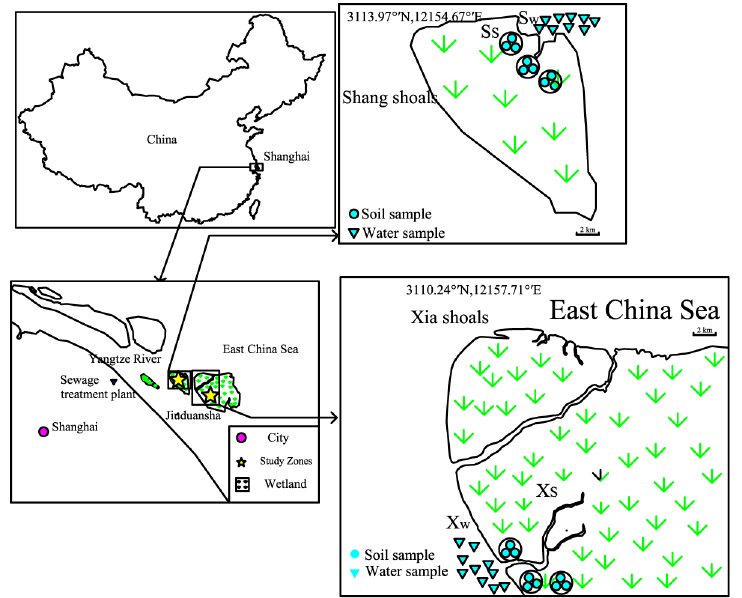
Fig 1. Map of the study areas of the Yangtze River estuary.